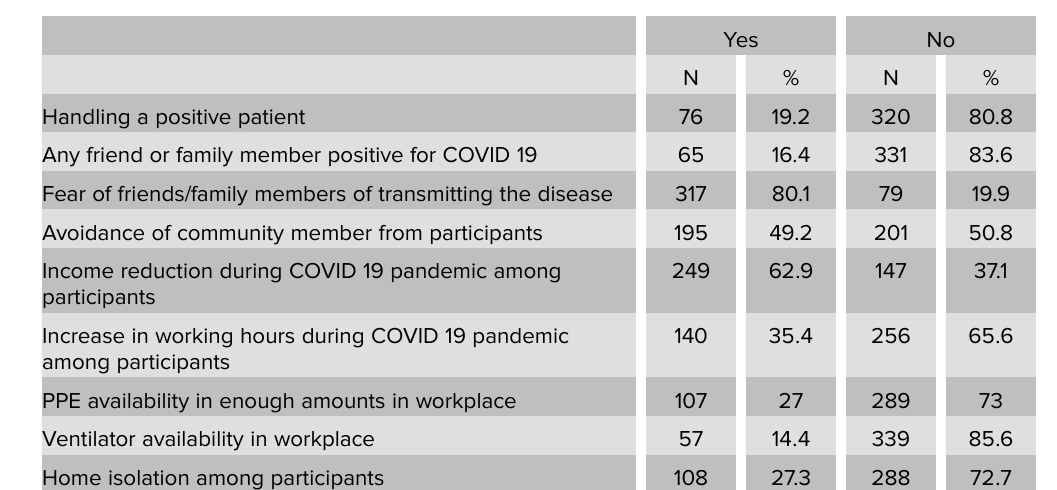
TABLE 2: COVID 19 exposure and perception